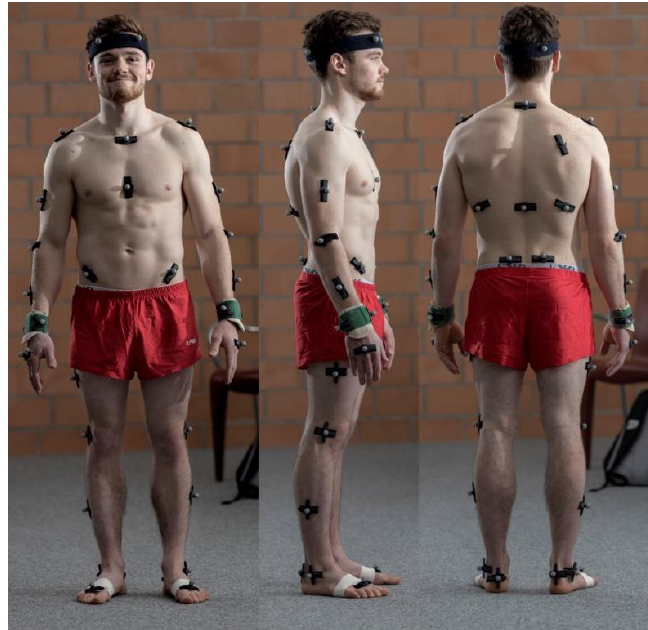
Figure 4. Plug-in Gait model: positioning of 43 markers for 3D analysis, attached to the athlete according to Vicon Plug-in Gait model [10].